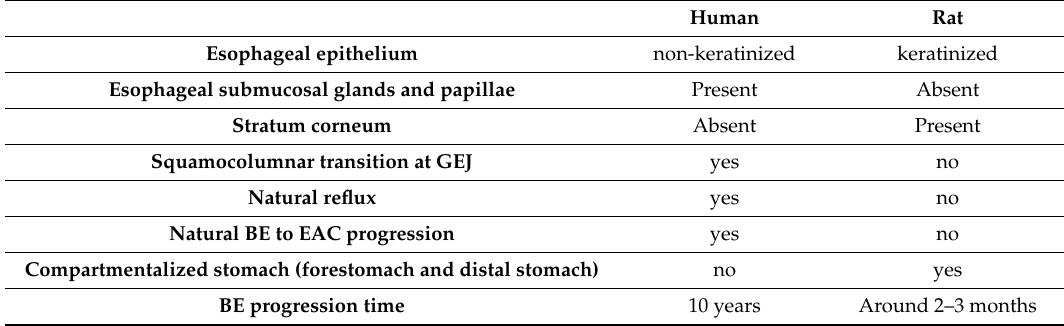
Table 4. Major di ff erences between human and rat esophagus physiology and Barrett’s esophagus (BE)